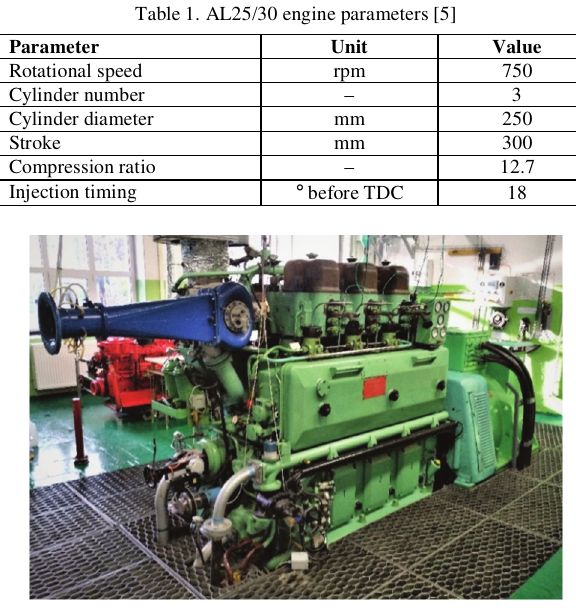
Fig. 1. Photo of the SULZER 3AL25/30 piston engine facility [7]